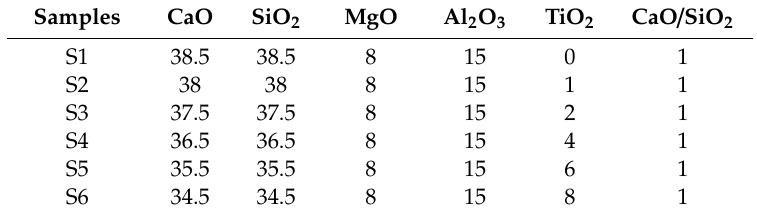
Table 1. The chemical composition of SiO 2 ‐ Al 2 O 3 ‐ CaO ‐ MgO ‐ based samples (wt%). Samples